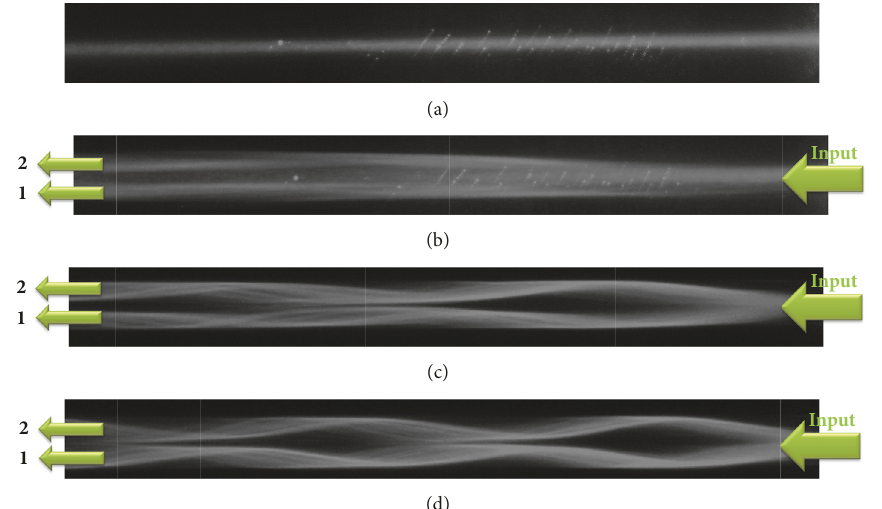
Figure 3: The guided light propagation by applying the same external voltages of (a) 0 V, (b) 1.5 V, (c) 2.2 V, and (d) 2.5 V in the two channels.